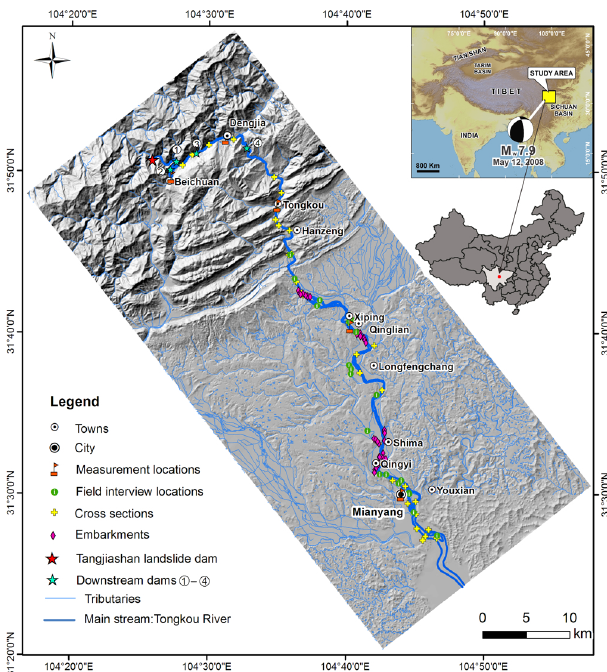
Fig. 1. Location of the Tangjiashan landslide dam and the layout of the field measurements. The measurement location in Beichuan is the same as the Beichuan hydraulic station.